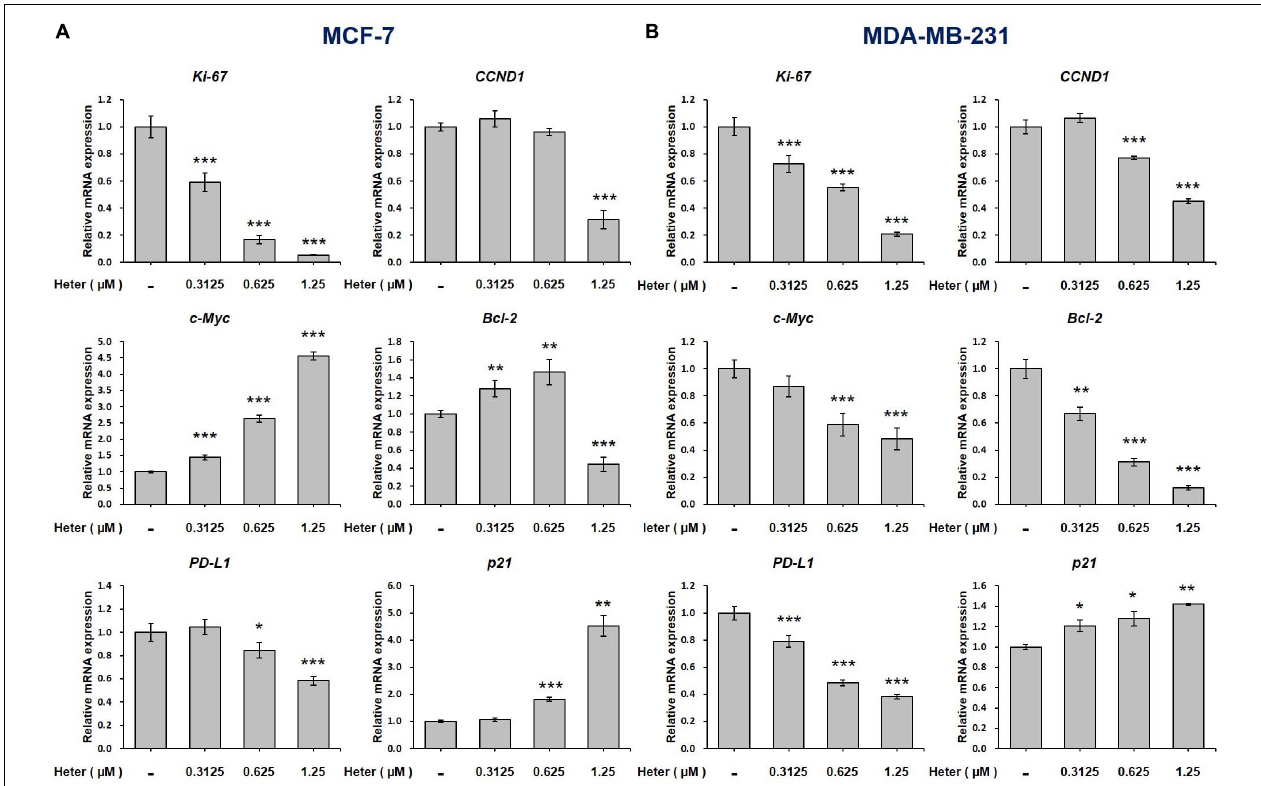
FIGURE 2 | Heteronemin regulates expression of ki-67 , CCND1 , c-Myc, Bcl-2 , PD-L1 , and p21 in breast cancer cells. (A) MCF-7 and (B) MDA-MB-231 cells were treated with various concentrations of heteronemin for 24 h. Total RNA was extracted. qPCR analyses were conducted for Ki-67, CCND1, c-Myc, Bcl-2 , PD-L1 , and p21 . The number of independent studies ( n ) = 3. * p < 0.05, ** p < 0.01, *** p < 0.001, compared to the untreated